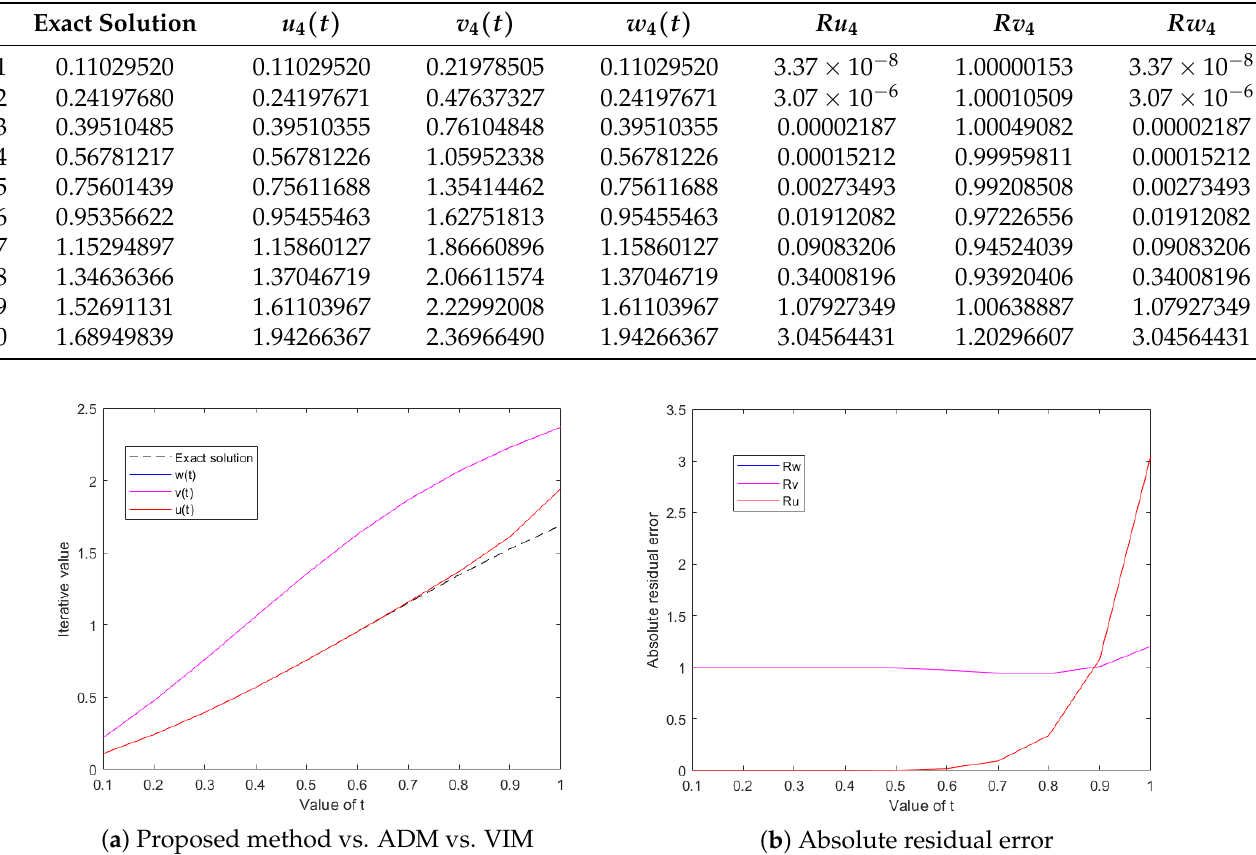
Figure 2. Comparison of numerical solutions and absolute residual errors obtained by the proposed method and existing methods for 0 ≤ t ≤ 1 of Example 2 with the available exact